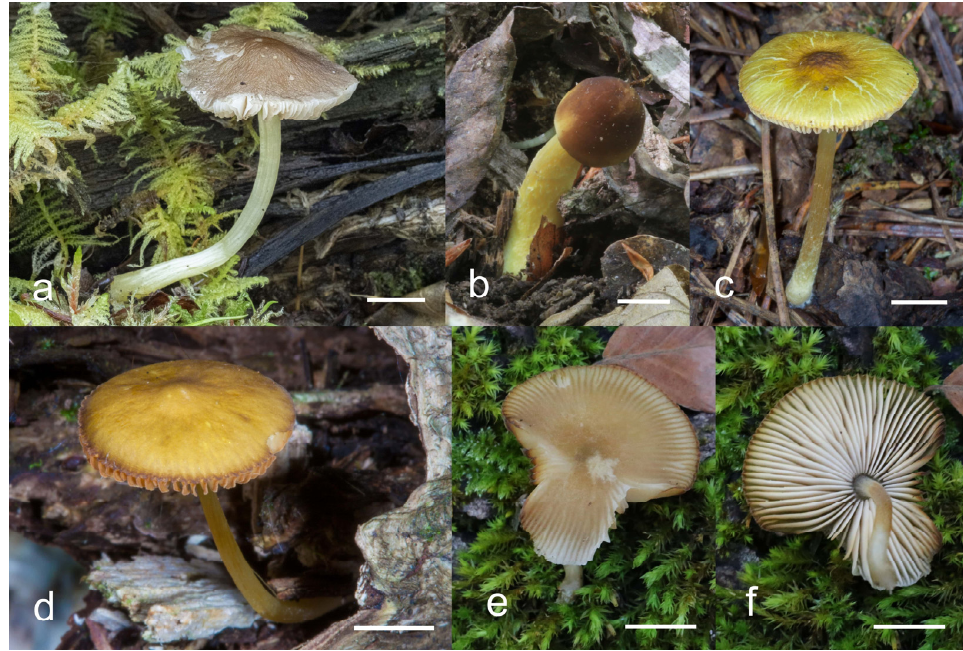
Figure 6. Pluteus aff. romellii basidiomata in situ: ( a ). LE 313599, ( b ). BRNM792987, ( c ). LE313340, ( d ). LE312975, ( e , f ). OKTR438. Scale bars 1 cm. ( d ). LE312975, ( e , f ). OKTR438. Scale bars 1